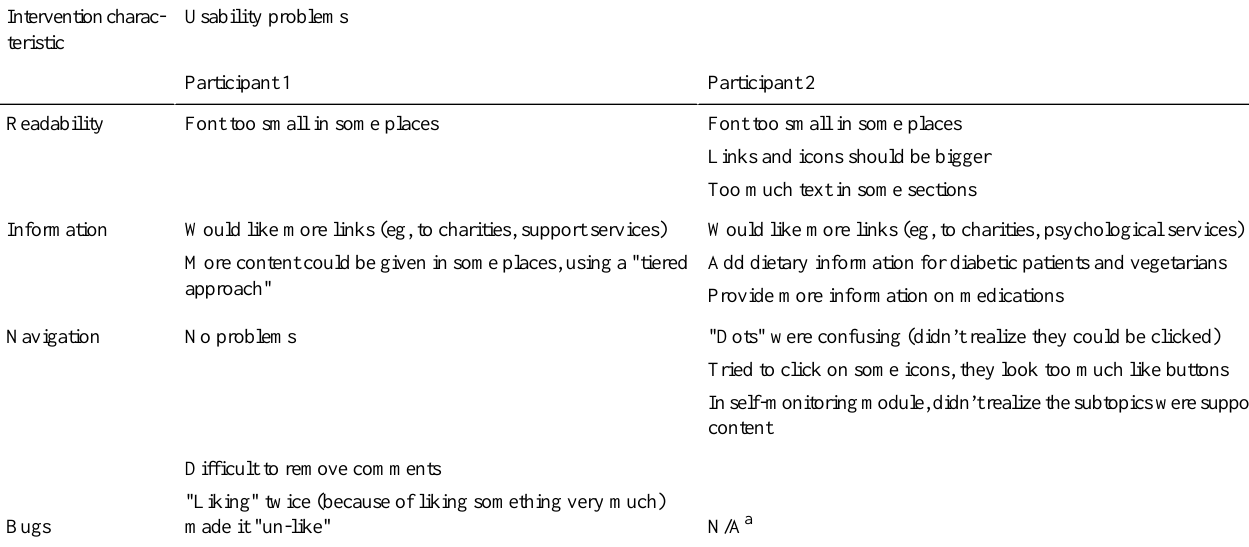
Table 3. Usability problems identified in think-aloud